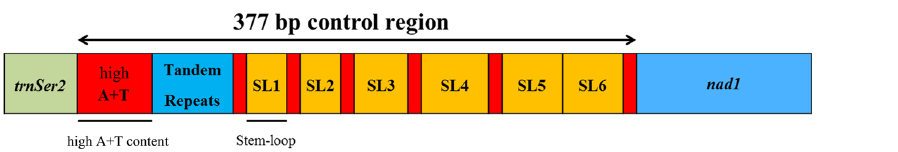
Figure 6. Predicted structural elements in the control region of A. borneensis . The regions with high A + T content are indicated by red shaded rectangles. Stem-loop regions are demarcated by orange